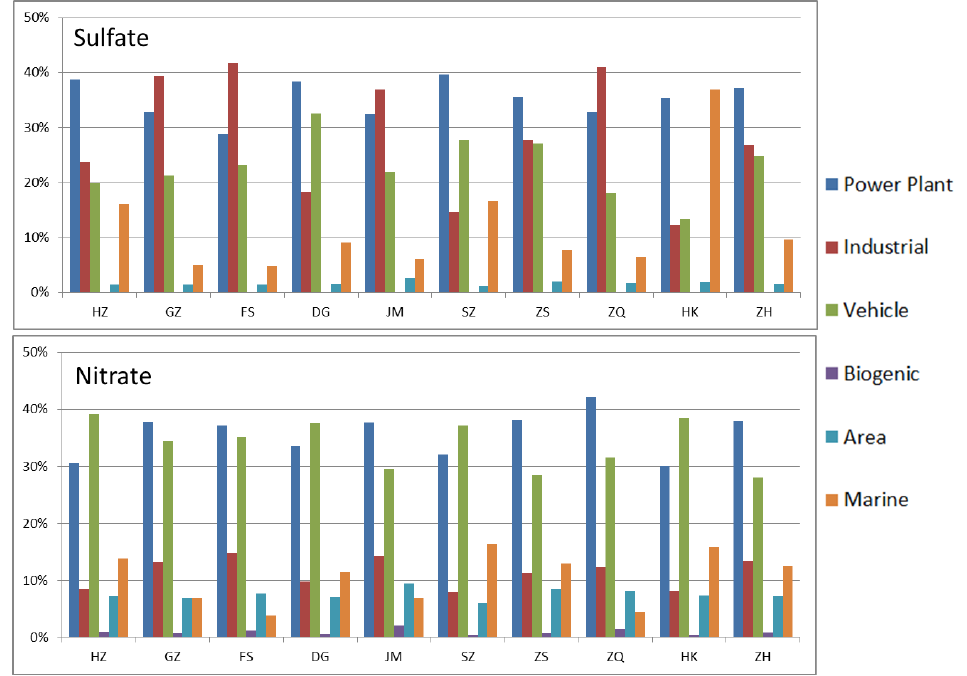
Figure 5. Source category of sulfates and nitrates over ten cities over the PRD region in August.